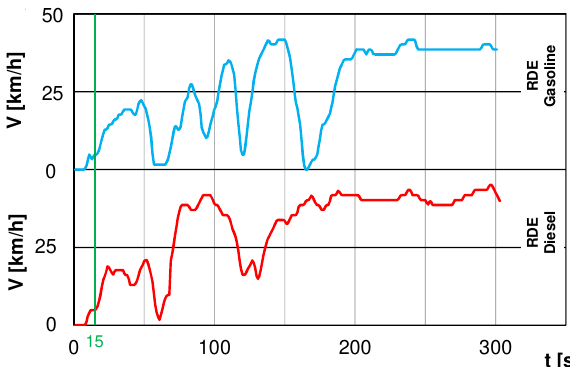
Fig. 7. The vehicles velocity during the phase of the engine cold start